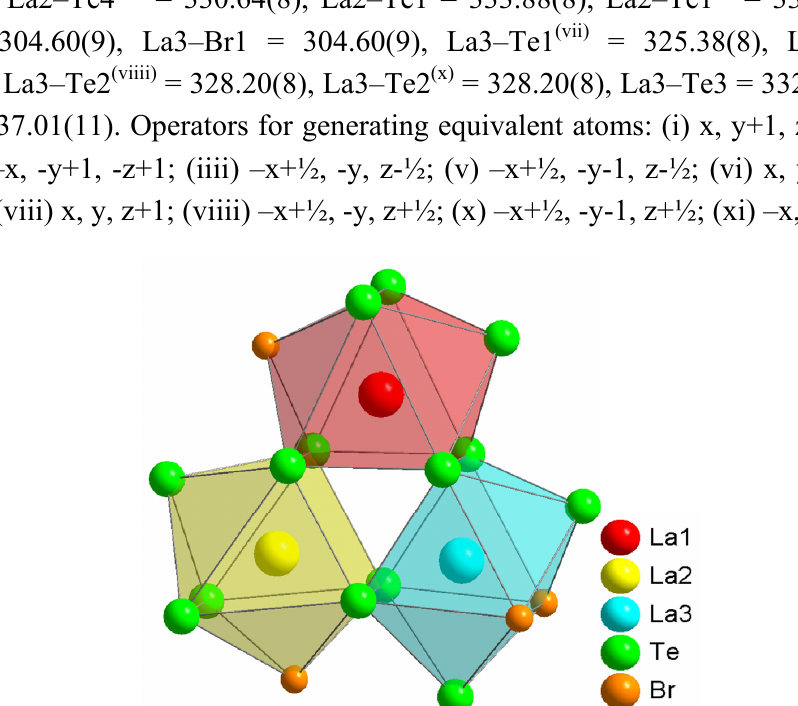
Te Br in the crystal structure of La 3 14 4